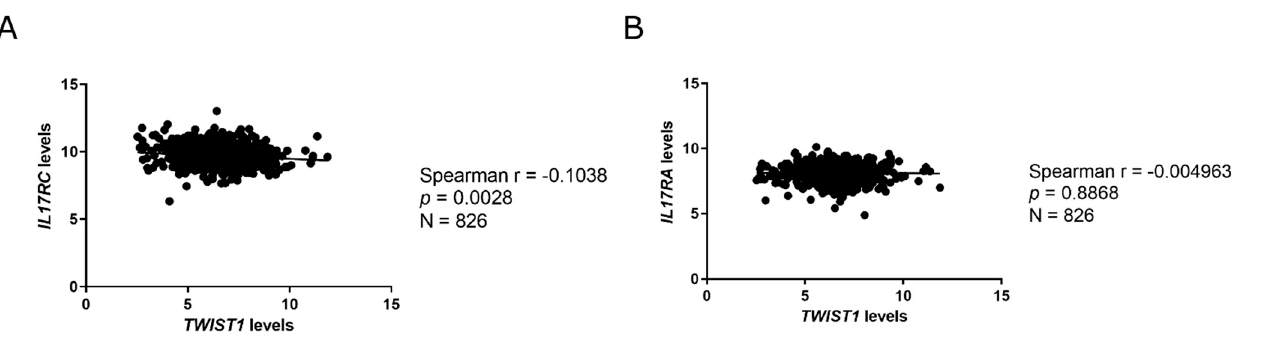
Figure 9. Spearman correlation analysis of the mRNA expression of TWIST1, IL17RC, IL17RA, IL17A, and IL17F in BC samples. Expression values were obtained from TCGA through Linkedomics tools. ( A ) TWIST1 × IL17RC, ( B ) TWIST1 × IL17RA, ( C ) TWIST1×IL17A, ( D ) TWIST1 × IL17F. 3. Discussion Twist1 is an evolutionarily conserved TF initially described as an essential regulator of gastrulation in Drosophila sp. [19], but which also plays a critical role in the embryonic development of Homo sapiens [20]. The main pathological functions attributed to Twist1 in human cancers are related to invasion and metastasis by promoting EMT in solid tu- mors [8]. In BC, Twist1 is described as the master regulator of metastasis [9]; however, several issues involving its role in different types and stages of human cancers remain to be addressed, particularly in BC subtypes. The present study demonstrated the strong association between Twist1 and IL-17 signaling in HER2+ BC, suggesting a role for Twist1 in immune processes, beyond EMT. Initially, the expression of TWIST1 , SLUG , and SIP1 was evaluated individually and compared to patient data from the Brazilian National Cancer Institute cohort, which is a strictly selected cohort of invasive ductal carcinoma (IDC) containing all the relevant clini- copathological information (Table 2). Although the TNBC group has been more strongly associated with the EMT expression profile [21], we found significantly increased expres- sion of TWIST1 in HER2+ BC samples (Figure 1), which is in accordance with Qiao et al. [22]. Table 2. Clinicopathological characteristics of patients. Clinical Characteristic n = 46 % = 100 Age, yr Early onset (20–50) Late onset (51–80)